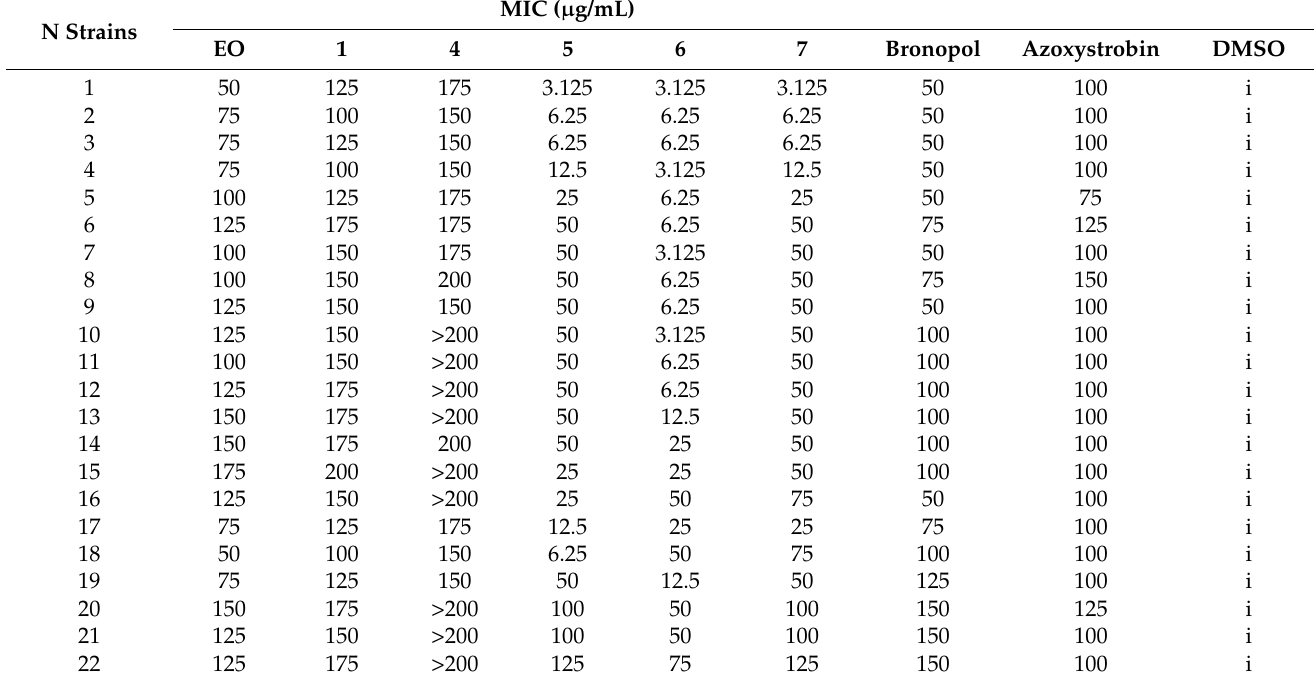
Table 2. MIC values a of leaf EO, safrole and compounds 4 – 7 against mycelium at 48